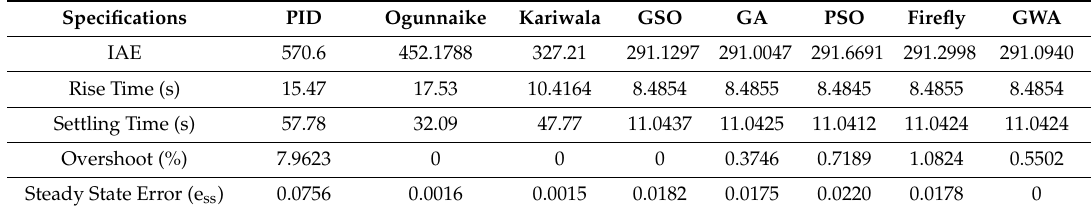
Table 15. Example 2: Performance comparison of di ff erent tuning methods and